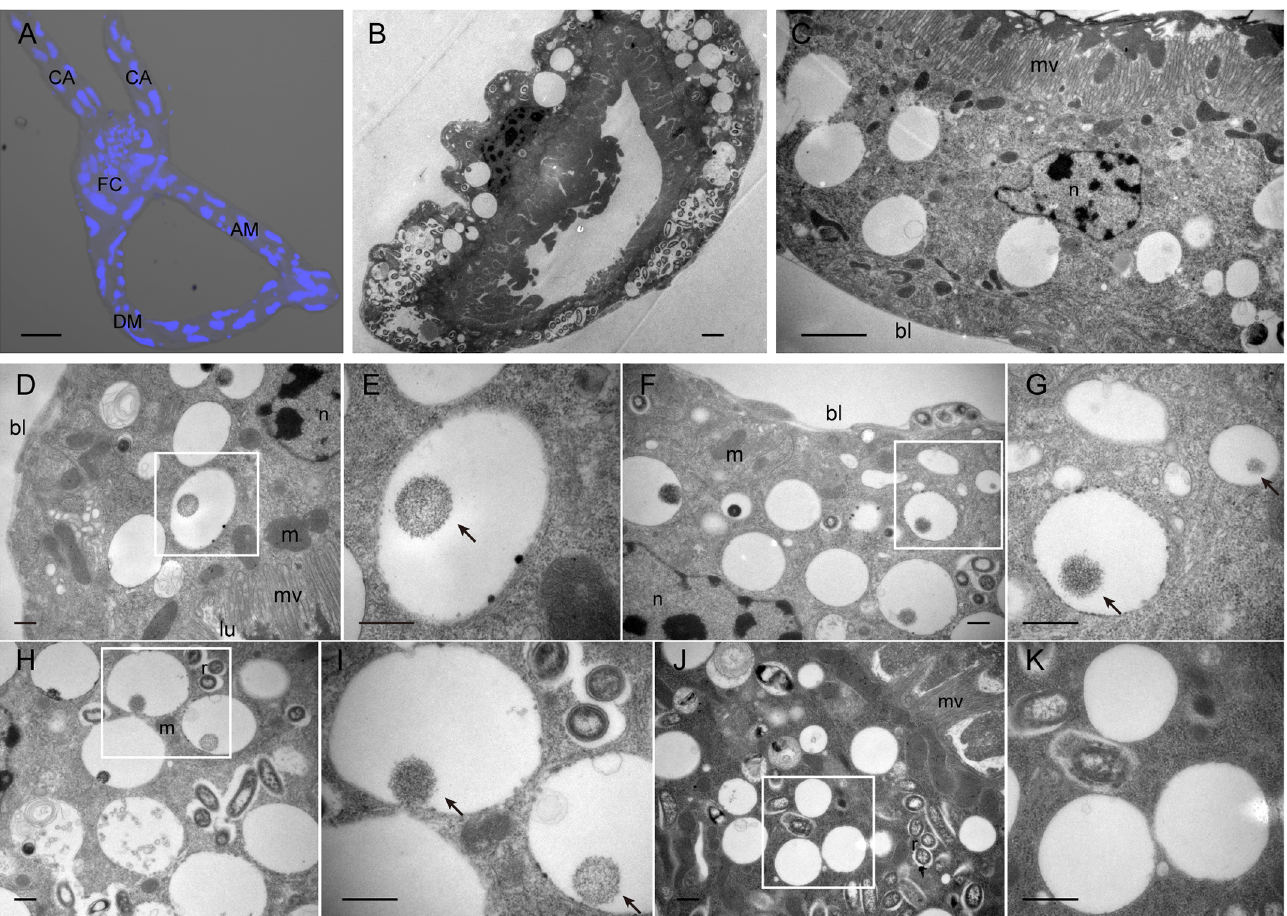
Fig 2. Overview and electron microscopy observations of whitefly midgut. (A) Dissected alimentary canal of whitefly B . tabaci , showing the filter chamber (FC), ascending midgut (AM), descending midgut (DM) and gastric caecum (CA). Blue signal indicates nuclei of cells. Scale bar 50 μ m. (B) Electron micrograph of midgut cross section. Scale bar 2 μ m. (C) Image of midgut exhibiting epithelial cells and microvilli ( mv ); bl basal lamina. Scale bar 2 μ m. (D-K) Midguts of whiteflies exposed to TYLCV-infected tomato plants for a 7 d AAP (D-I) or of control whiteflies that fed on uninfected plants (J-K) were osmium-fixed and prepared for electron microscopy. Large paracrystalline accumulations of TYLCV-like particles can be observed in the apical region close to microvilli ( mv ) (D), close to the basal lamina ( bl ) (H), or between these locations (F). Arrows indicate paracrystalline accumulations of TYLCV-like particles which were always found enclosed by membrane. The membranous vesicles in control whiteflies are devoid of TYLCV-like particles (J). Panels E, G, I, and K show the enlarged images. bl basal lamina, m mitochondrion, n nucleus, lu midgut lumen, r Rickettsia. Scale bar 500